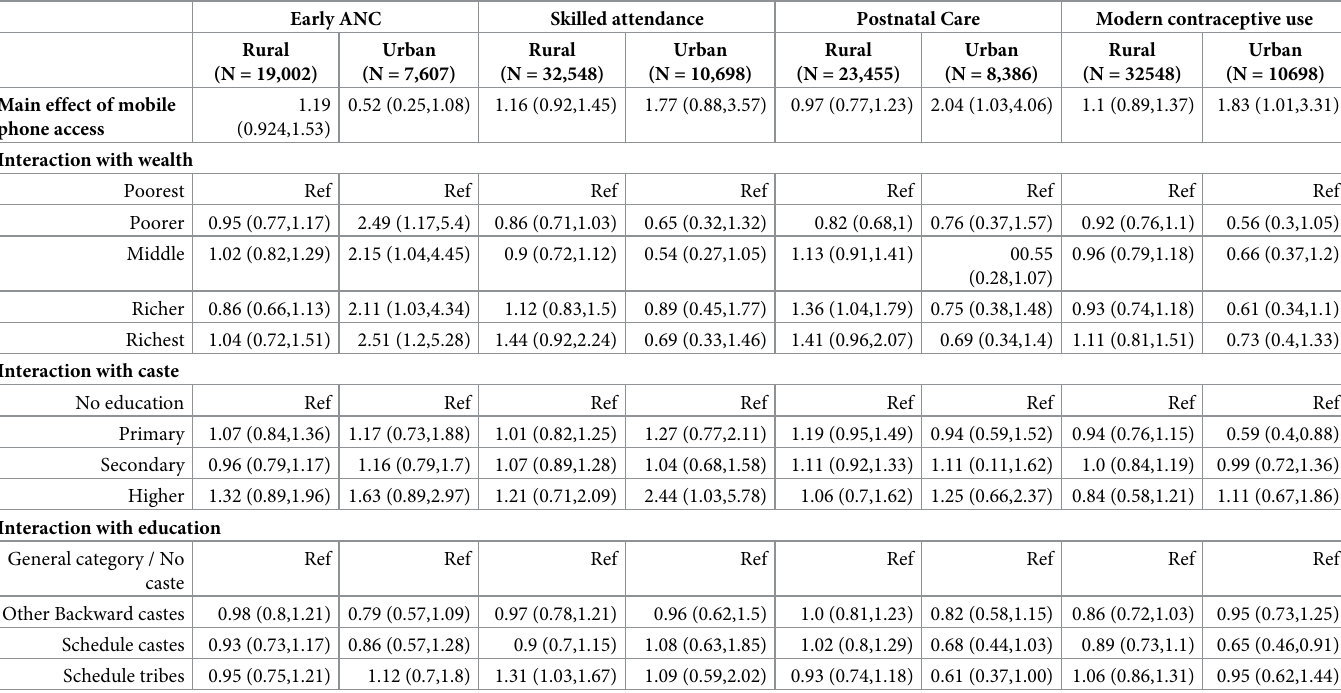
Table 3. Effect sizes for women’s mobile access for selected indicators of utilization of health care (adjusted odds ratios and 95% confidence intervals). Early